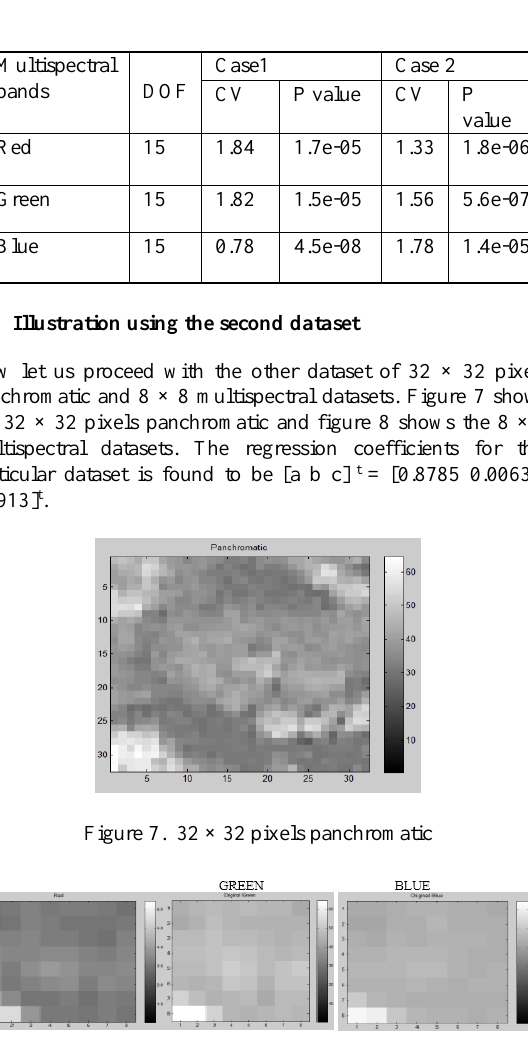
Figure 8. 8 × 8 multispectral datasets.